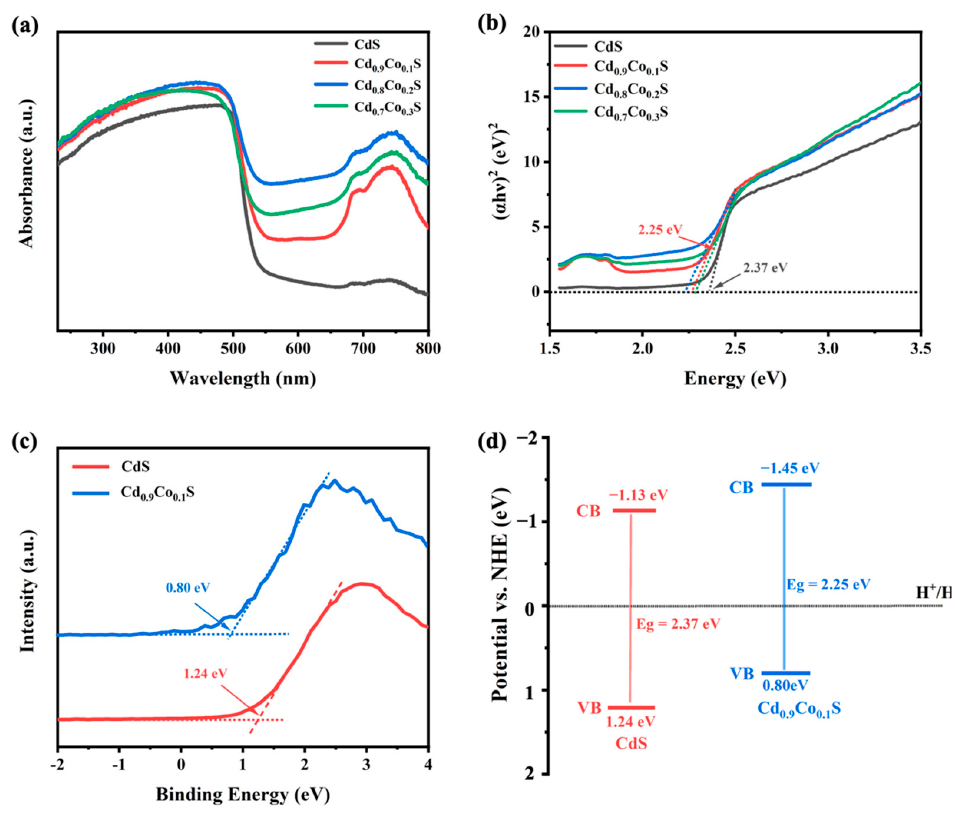
Figure 6. UV–vis diffuse reflectance spectra ( a ), corresponding Tauc plots ( b ), XPS valence band spectra ( c ), and Schematic band structures of pure CdS and Cd 0.9 Co 0.1 S NRs ( d ).